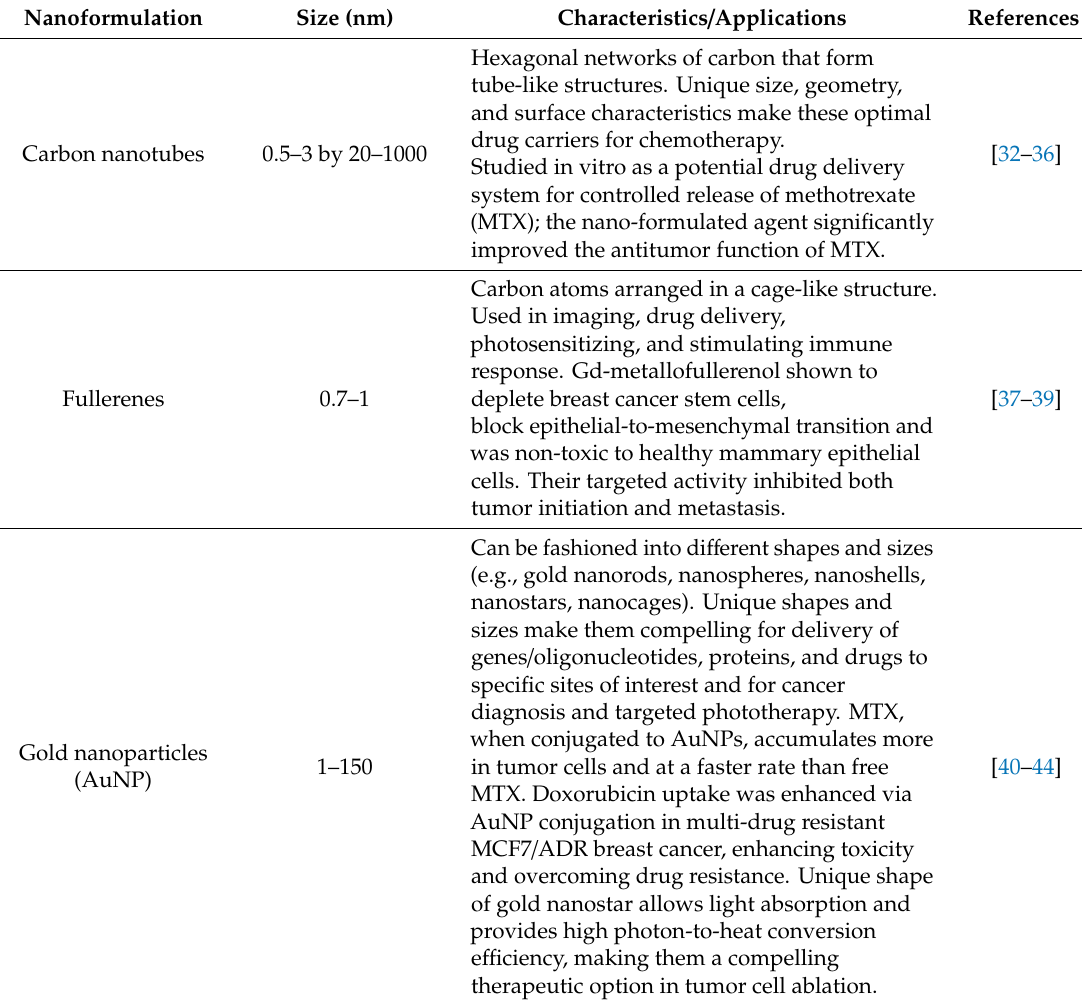
Table 1. Novel nanoformulations and their characteristics or applications in oncological